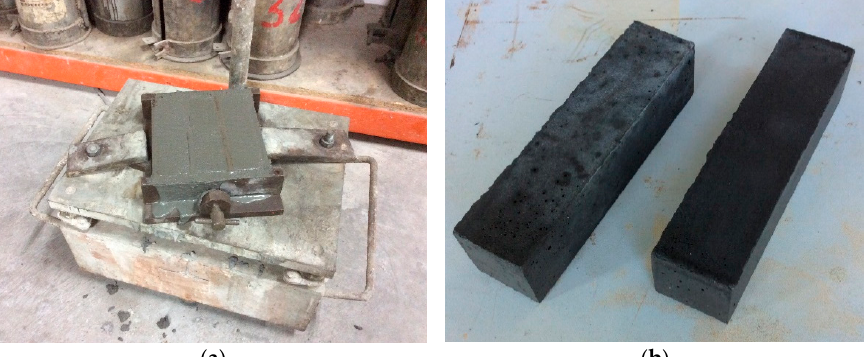
Figure 3. Mortar manufacture ( a ). Mortar specimens ( b ).